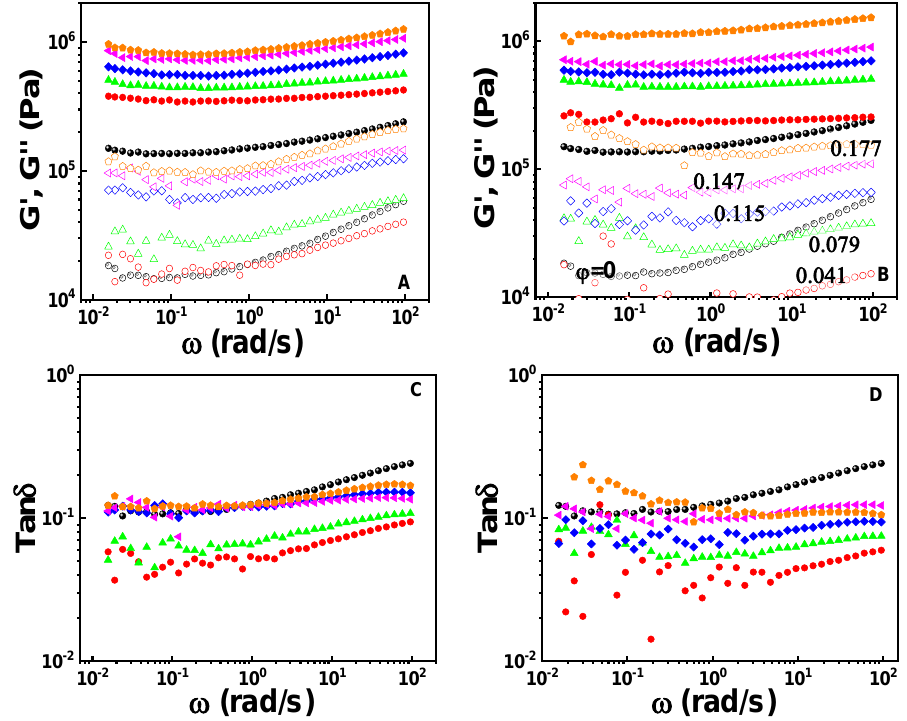
Figure 7. Storage modulus ( G ’, solid symbols), loss modulus ( G ’’, hollow symbols) and loss tangent (tan δ ) as a function of frequency ( ω ) for the gum and filled vulcanizates containing Si69 ( A and C ) or Si69/[EMIM]OAc ( B and D ) at strain amplitude ( γ ) 0.03%.